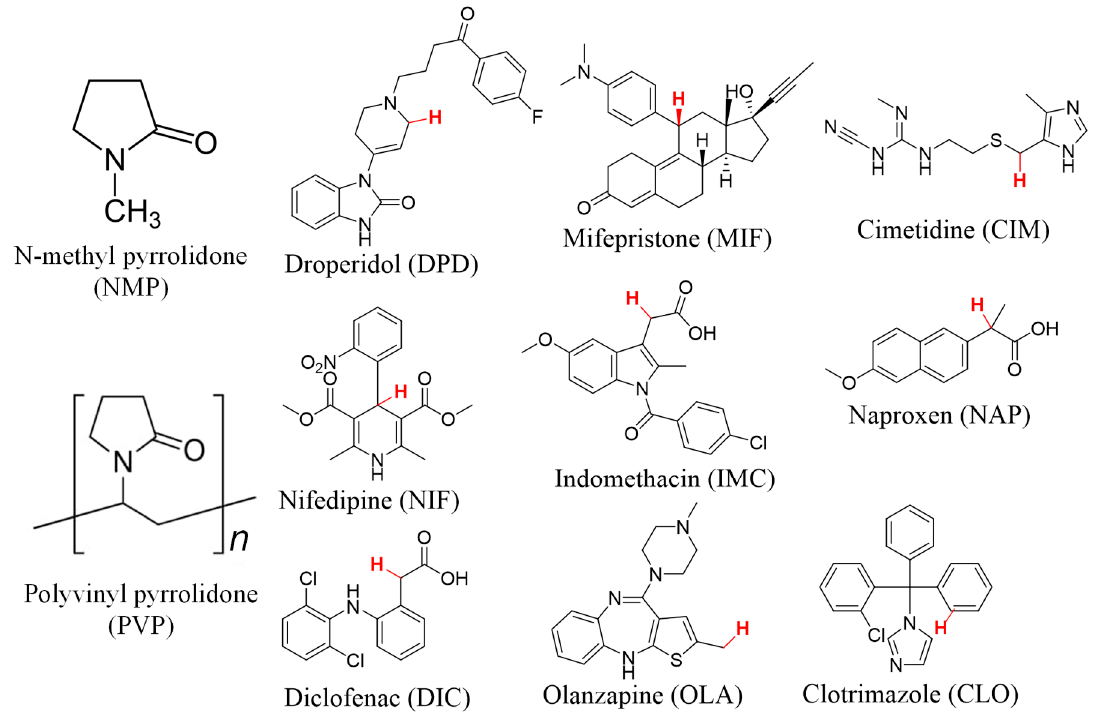
Figure 1. Chemical structure of NMP, PVP, and the selected drugs. Each drug’s H-atom with the lowest C–H BDE value is shown in red as reported in reference [32]. For PVP, n is the number of repeating monomer units.